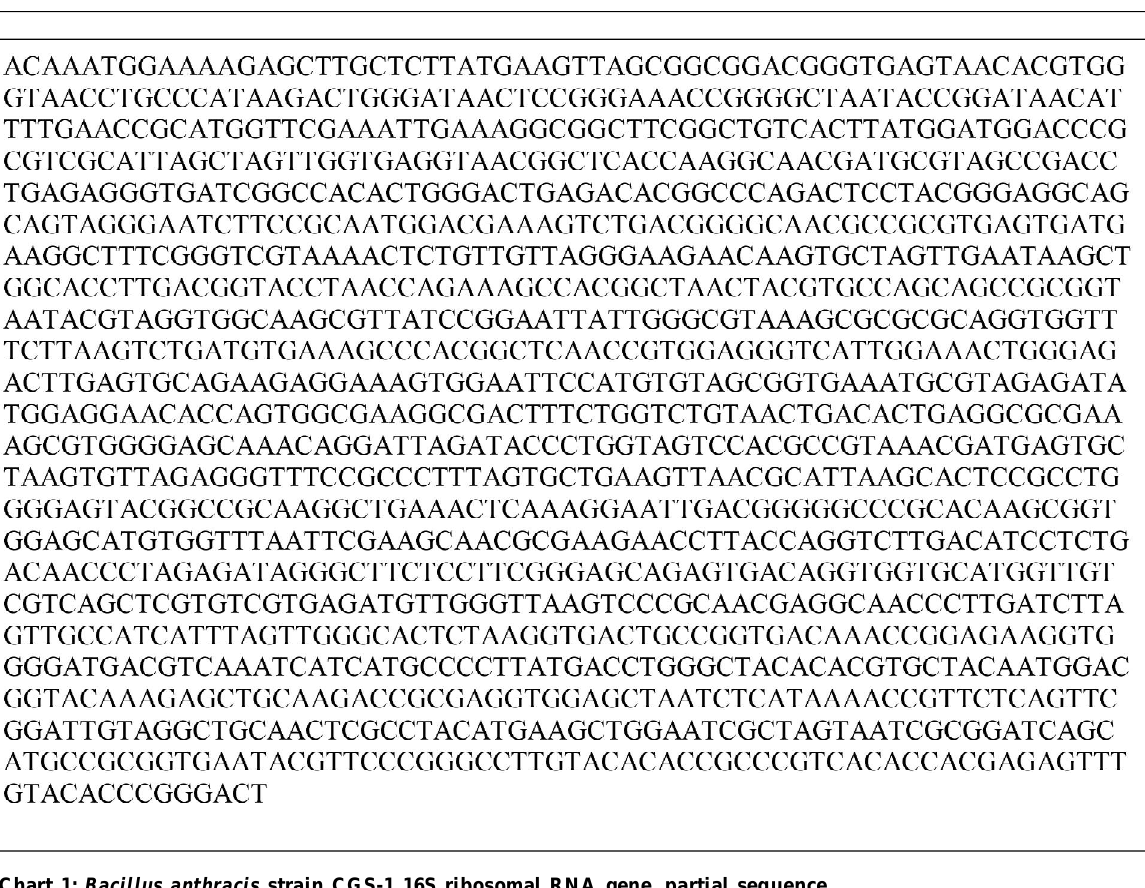
Chart 1: Bacillus anthracis strain CGS-1 16S ribosomal RNA gene, partial